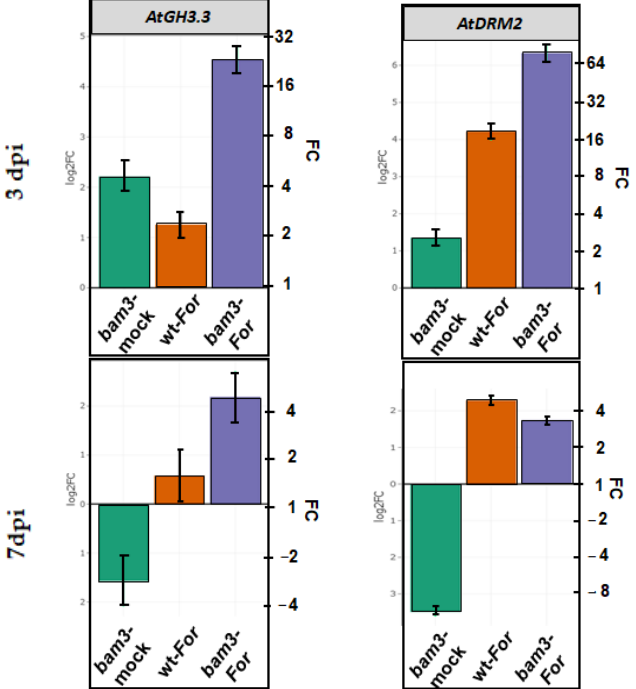
Figure 9. Comparative transcriptional analysis of GH3.3 and DRM2 related to auxin metabolism. Fold change represents the relative difference in expression between each treatment (i.e., mock bam3 plants, For-inoculated wt plants, and For-inoculated bam3 plants) and the control (i.e., wt mock plants) (x axis) at three and seven dpi. Three independent biological replicates, with two technical replicates, were analyzed, and β -ACTIN2, β -ACTIN7, and β -ACTIN8 were used as reference genes. Bars indicate the 95% confidence interval of the estimates (2*SE) in all panels. Statistical analysis was performed with linear mixed models. Estimates for which the confidence interval includes the baseline value 0 (1 in fold-change scale) are not significantly different from control at α = 5%.